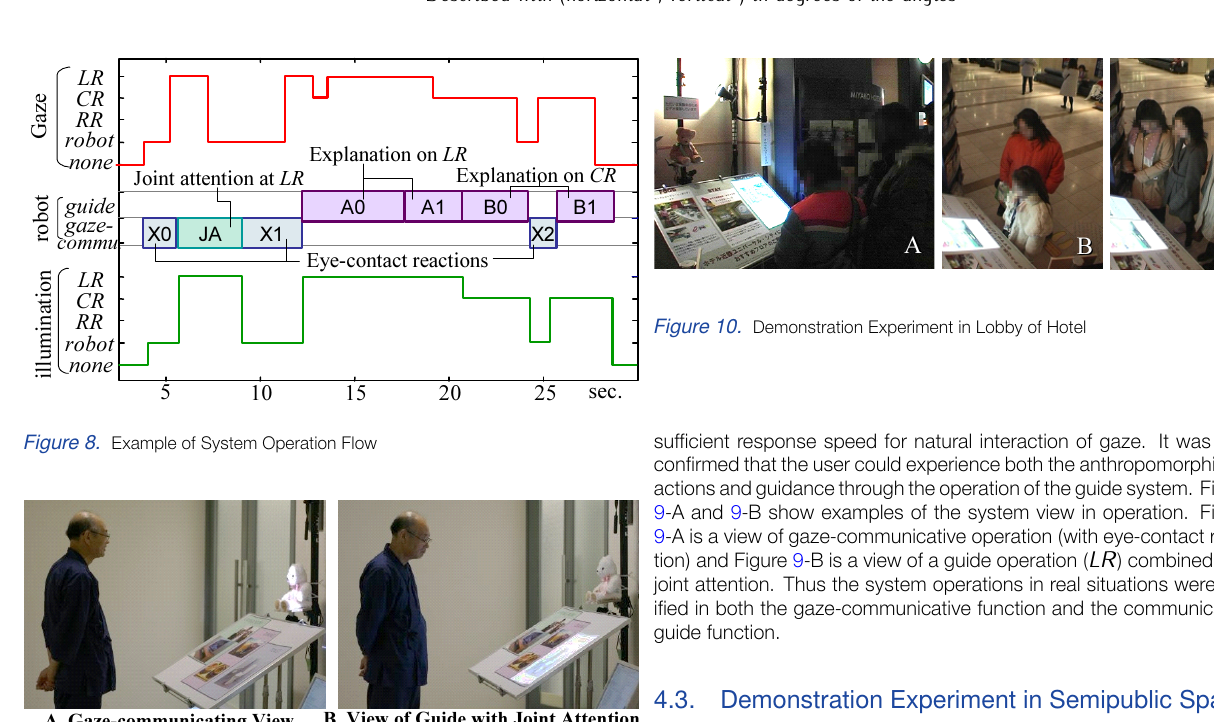
Figure 9. System Operation View